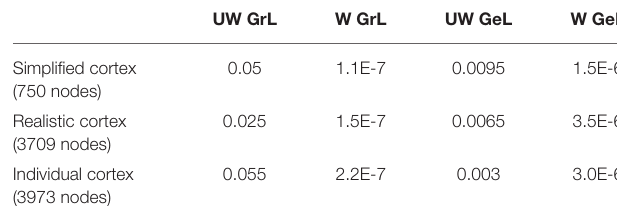
TABLE 1 | Optimal values for σ